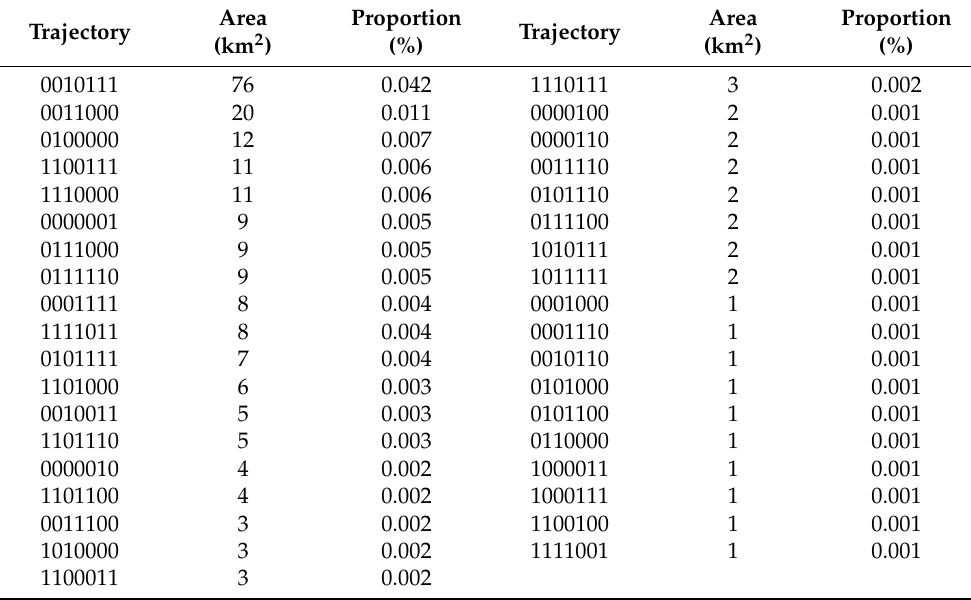
Table 3. Proportions of 37 irregular change trajectories to the total area.